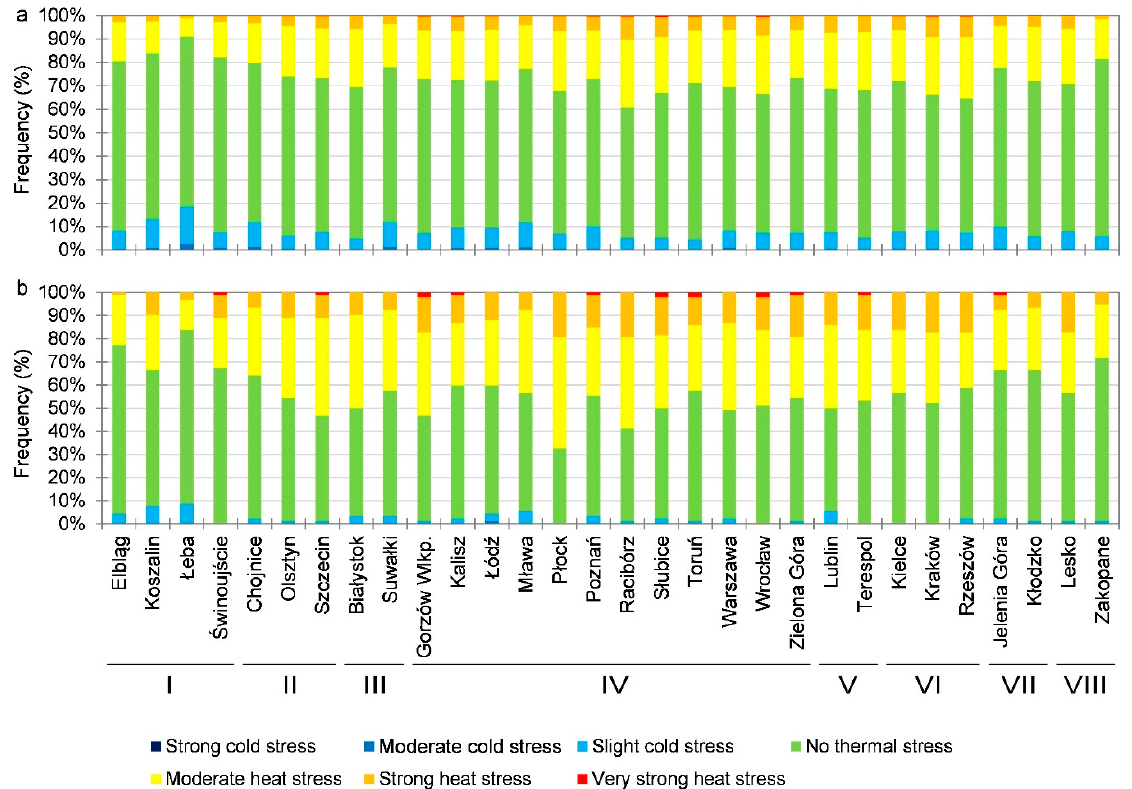
Figure 4. Frequency of occurrence of particular categories of heat stress in the summer season in the period 1966–2019 ( a ) and 2019 ( b ).